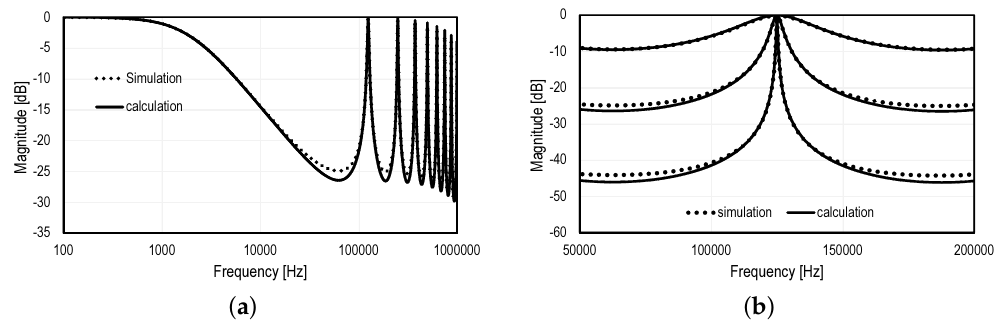
Figure 9. Simulated transfer function of the N-path filter from Figure 8 with SpectreRF c (cid:13) compared to the calculated transfer function from Equation (12) for N = 16 and f mod = 125 kHz. ( a ) Both transfer = 100, and the impact of the sinc lobes; ( b ) a zoom in a functions, in the Log frequency scale with C P C R linear scale for C P set to 1, 10 and C R